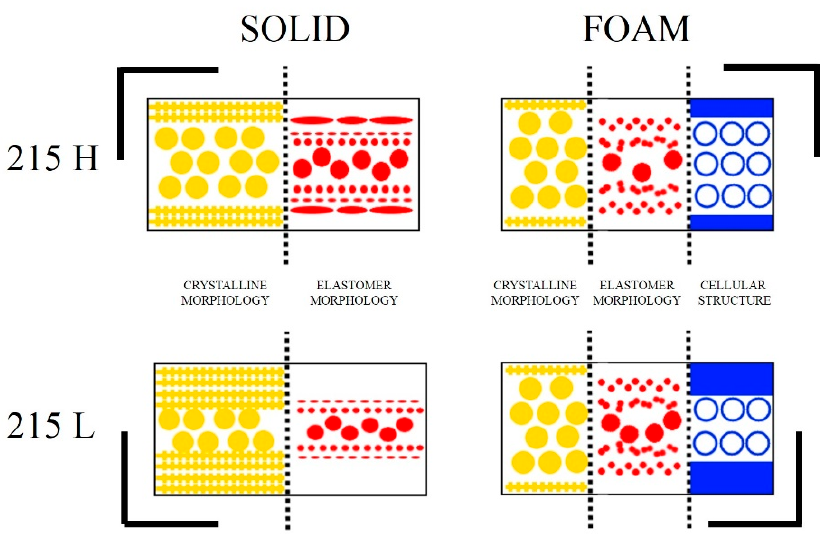
Figure 8. Schematic model of the elastomer and crystalline morphology in the case of solids, adding the cellular structure in the case of the foamed